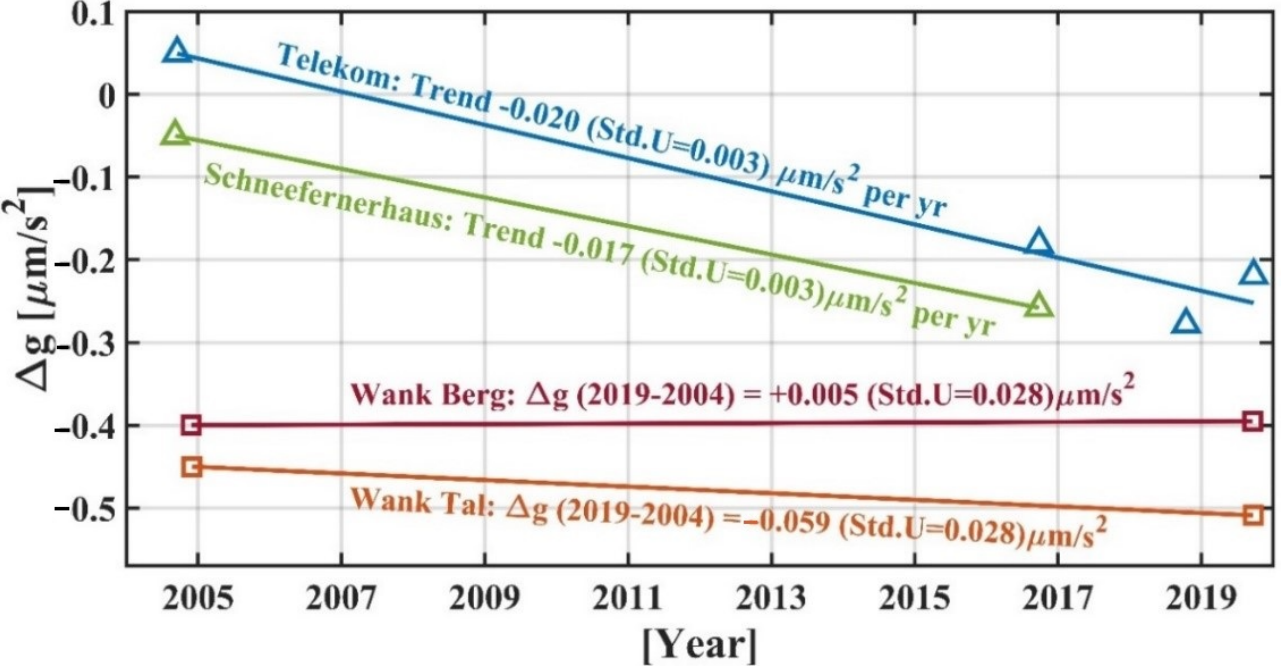
Figure 5. Gravity rates derived from Table 4 as observed at two top sites of Mt. Zugspitze and at Mt. Wank foot and summit. The significant gravity decreases of the Zugspitze sites are expressed as yearly averages to indicate a secular linear trend. Table 5. Gravity differences between the two Zugspitze stations Telekom (summit) and Schneefernerhaus 202 ( ≈ 300 m below summit) measured in 2004 (absolute gravimetry and centring) and in 2016 (relative gravimetry). From To Epoch Δ g Std.U